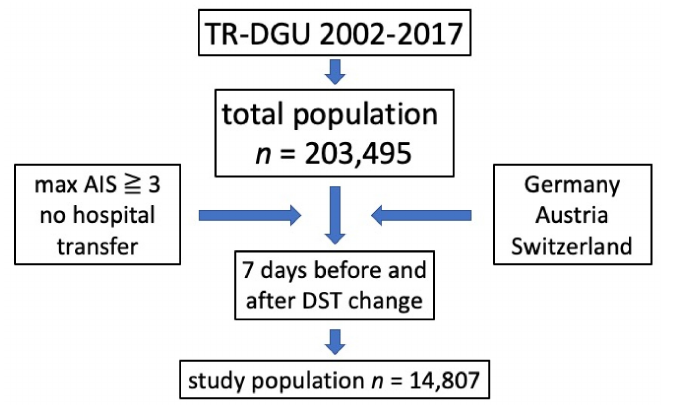
Figure 1. Inclusion criteria; max = maximum; AIS = abbreviated injury score; DST daylight saving